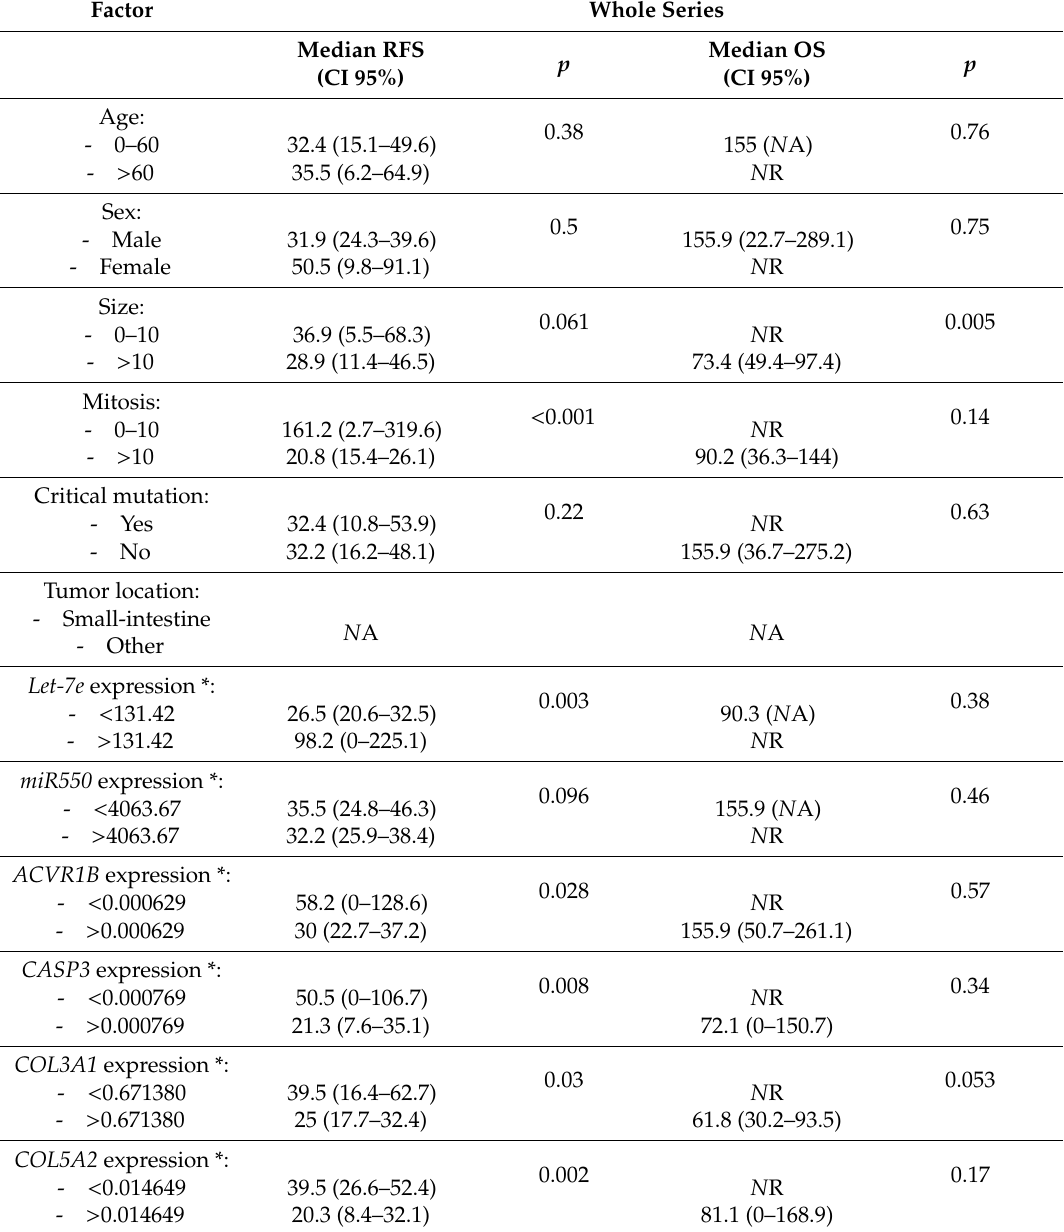
* Optimal cuto ff calculated using ROC